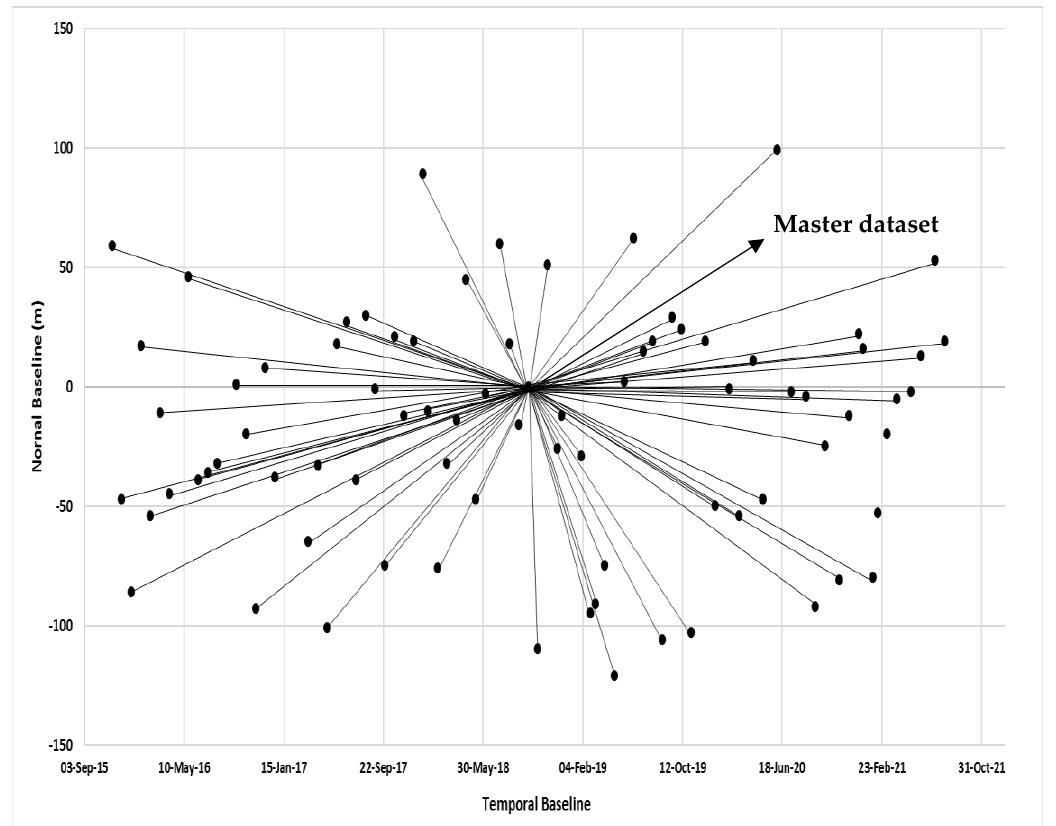
Figure 4. Dataset and spatial baseline details.